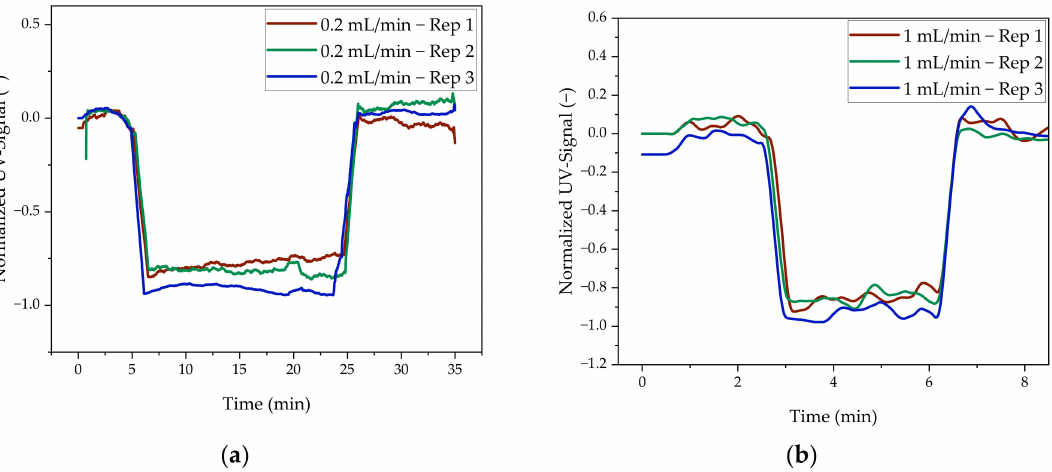
Figure 9. Normalized input signal of the slug. Recorded with a UV detector (200 nm) at a volume flow of ( a ) 0.2 mL/min and ( b ) 1 mL/min.